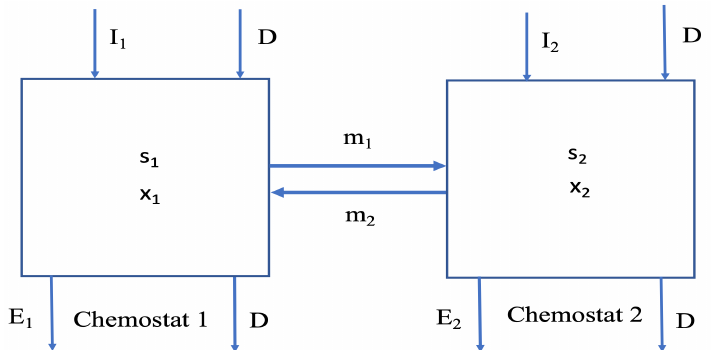
Figure 1. System of two connected bioreactors with fast